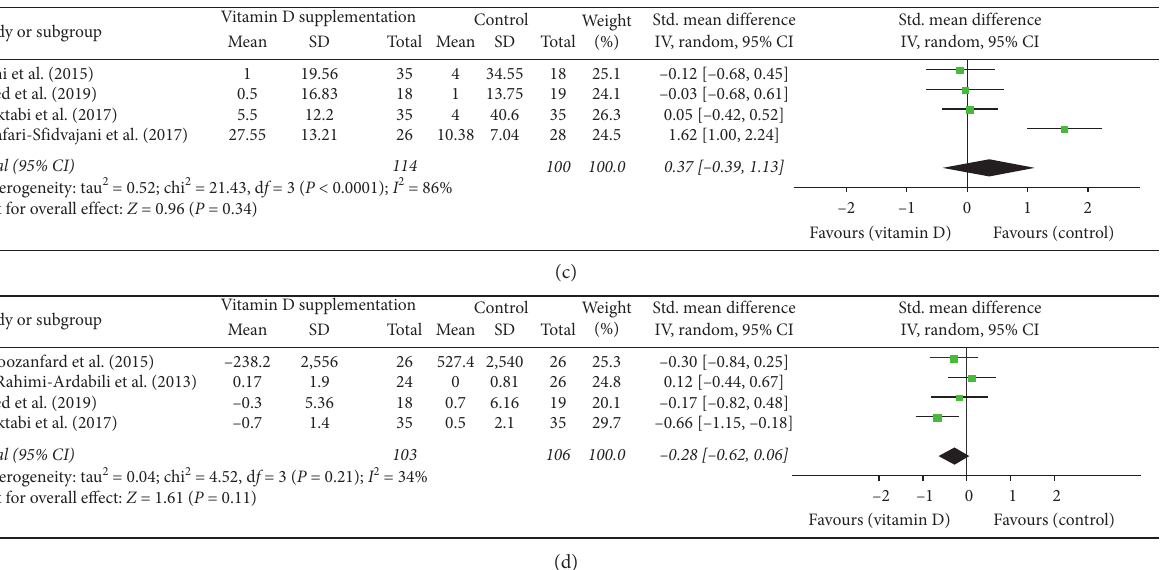
Figure 7: (a) Forest plot of total testosterone level in experimental and placebo groups. (b) Forest plot of DHEAS level in experimental and placebo groups. (c) Forest plot of SHBG level in experimental and placebo groups. (d) Forest plot of hs-CRP level in experimental and placebo